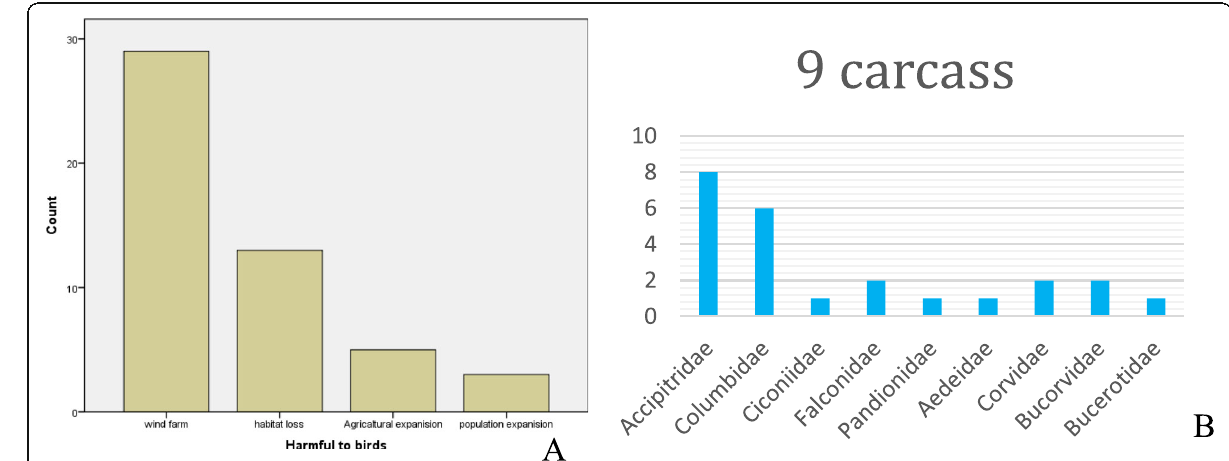
Fig. 2 Seasons that bird and bat species collide at wind